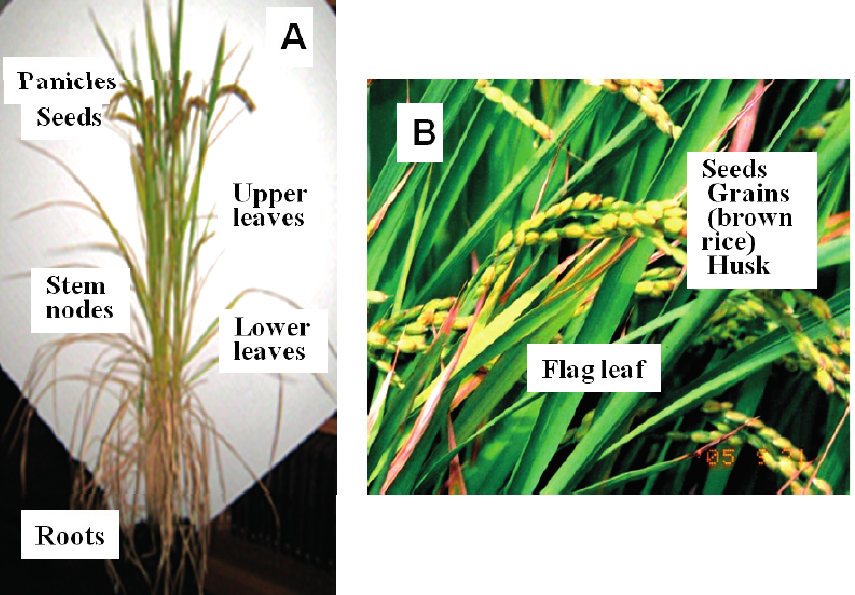
Figure 1. Rice plants (cv. Koshihikari) grown in potted soil ( A ) and in a field ( B ) at maturity. Recent field studies in Thailand by Simmons et al. [10] on Cd, Zn, and Fe accumulation in rice grains (unpolished rice) under Cd/Zn contaminated soils, containing 2.9 ‒ 284 mg·kg − 1 Cd, 254 ‒ 8036 mg·kg − 1 Zn, and 0.5 ‒ 25 mg·kg − 1 Fe, indicated that the harvested grains contained variable concentrations of Cd ranging from 0.02 to 5.0 mg·kg − 1 , but relatively constant concentrations of Zn (from 15 to 25 mg·kg − 1 ) and Fe (from 7.5 to 12.7 mg·kg − 1 ), although the concentrations of all three metals varied greatly in the stems and leaves. Thus, Zn and Fe levels in rice grains are little affected by the availability of Zn and Fe in the soil, while grain Cd levels vary greatly. Grain Zn concentrations in rice plants grown in the Philippines were unchanged by Zn fertilization (15 kg Zn·ha − 1 ), while this Zn fertilization increased straw Zn concentrations by 43% ‒ 95%